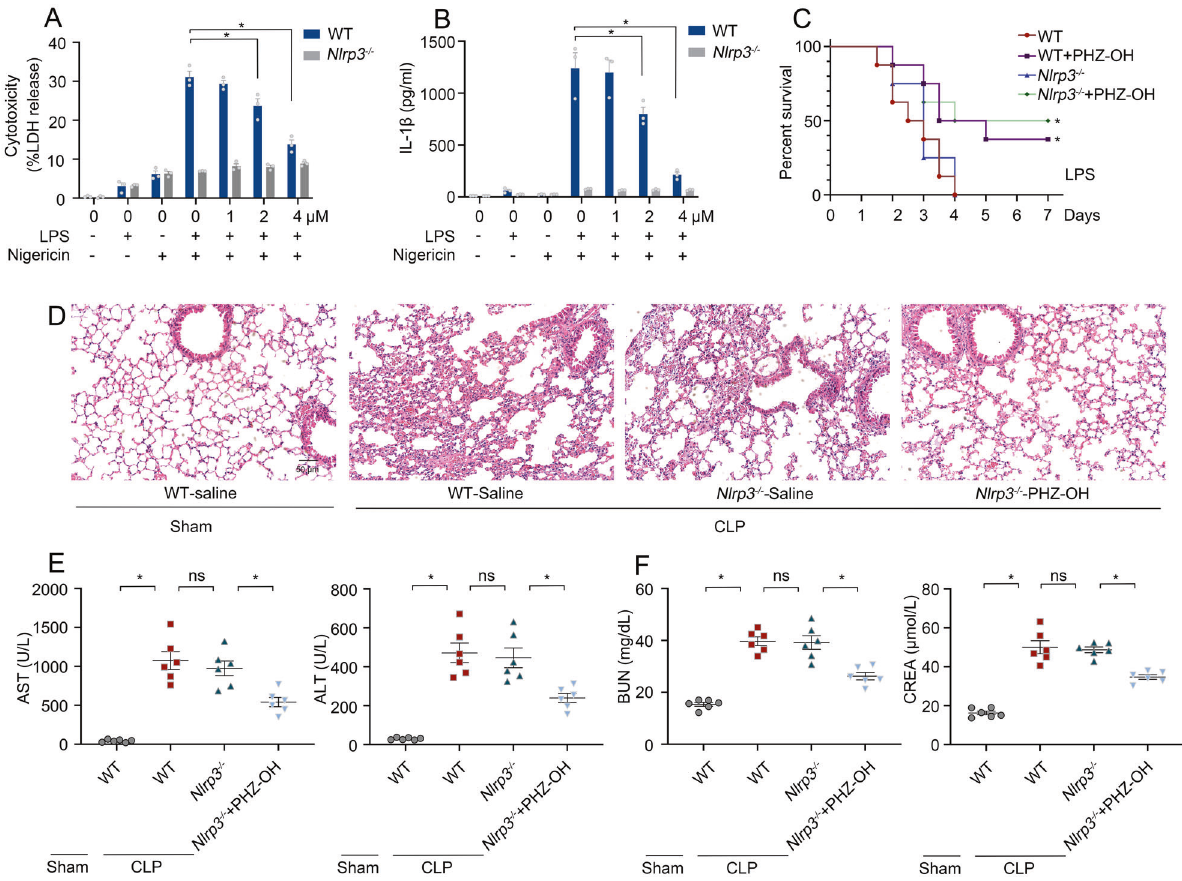
Fig. 3 PHZ-OH protects against bacterial sepsis independent of NLRP3 in fl ammasome. Cytotoxicity ( A ) and IL-1 β release ( B ) of mouse peritoneal macrophages primed using LPS (1 μ g/mL) for 3 h and treated with nigericin (10 μ M) for 1 h in the presence or absence of